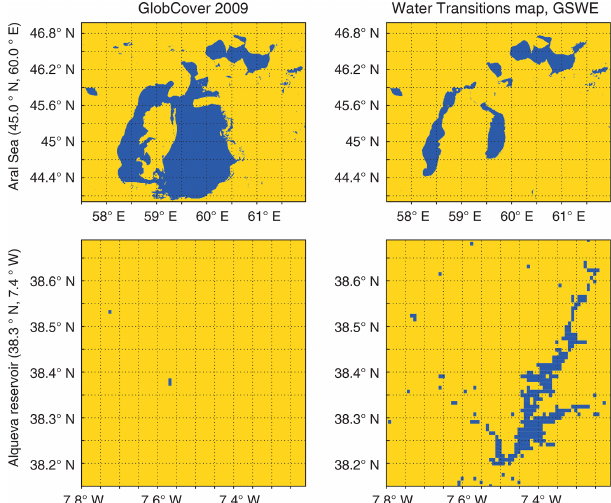
Figure 3. Water distribution from GlobCover 2009 and the GSWE Water Transitions map (only (1) permanent, (2) new permanent and (7) seasonal to permanent water classes are used); yellow colour indicates land, and dark blue indicates